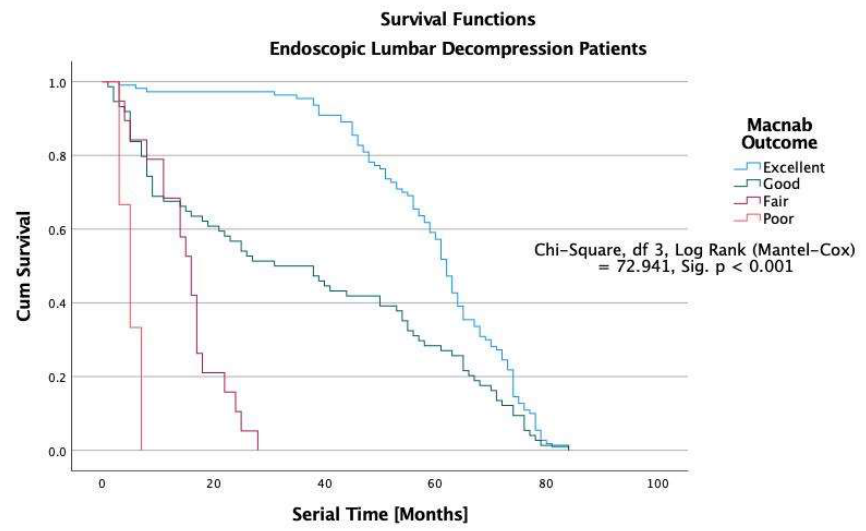
eight months with a standard error of 0.942, a lower boundary of 6.154 and an upper boundary of 9.846 months.